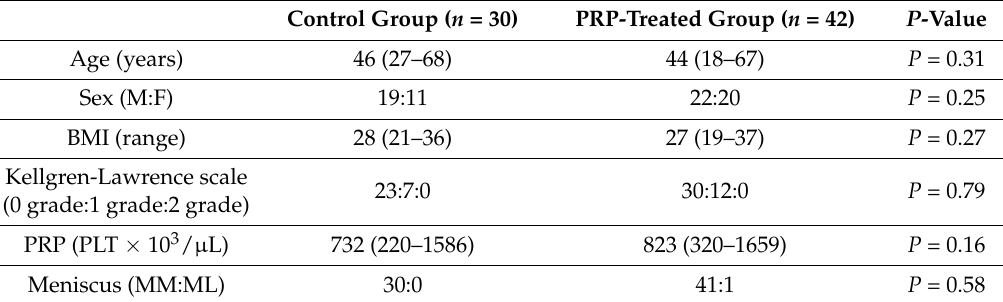
Table 1. Baseline characteristics of study patients in the control and PRP-treated